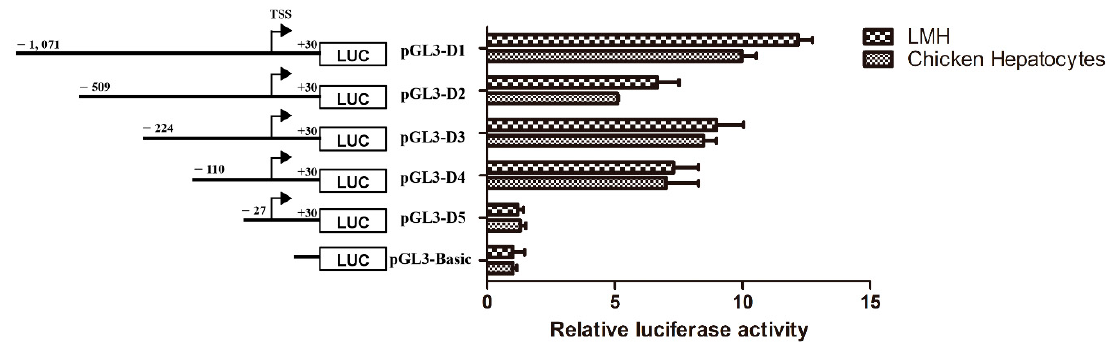
Figure 2. 5 ′ -deletion analysis of the chicken Abcg2 promoter activity. Five promoter constructs were transfected into LMH cells and chicken hepatocytes and assayed for luciferase activity. The left figure shows a schematic diagram of the truncated promoters and the right graph shows the corresponding luciferase reporter assay results. The results are presented as the normalized relative luciferase activity levels (Firefly/Renilla).